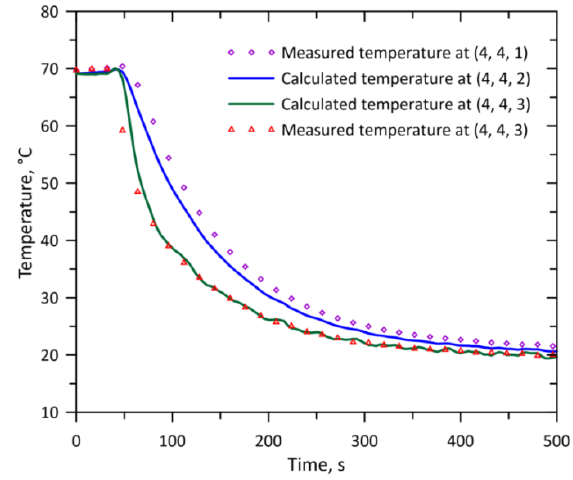
Figure 6. Calculated and measured temperature values on the exposed slab surface at the point (4,4,3).